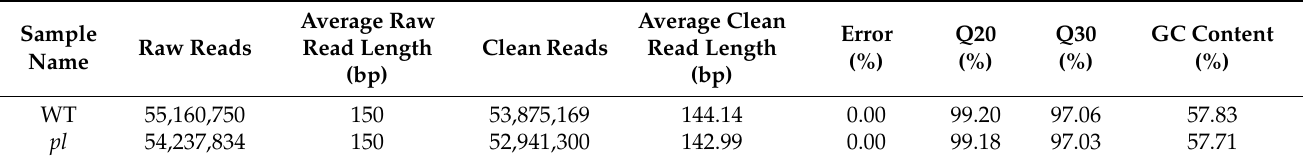
Table 1. Summary of reads of the samples retrieved from Illumina sequencing.